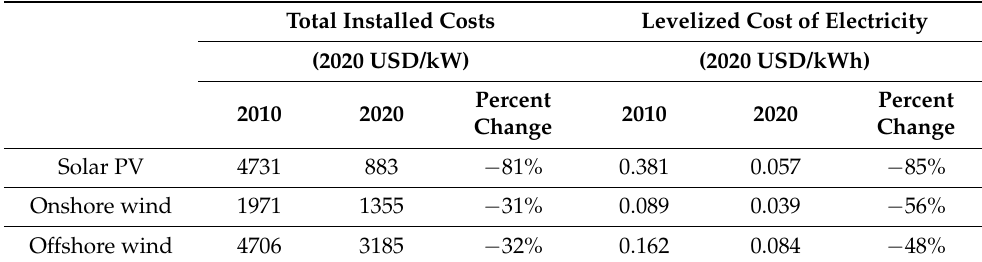
Table 1. Total installed costs and LCOE trends by technology, 2010 and 2020